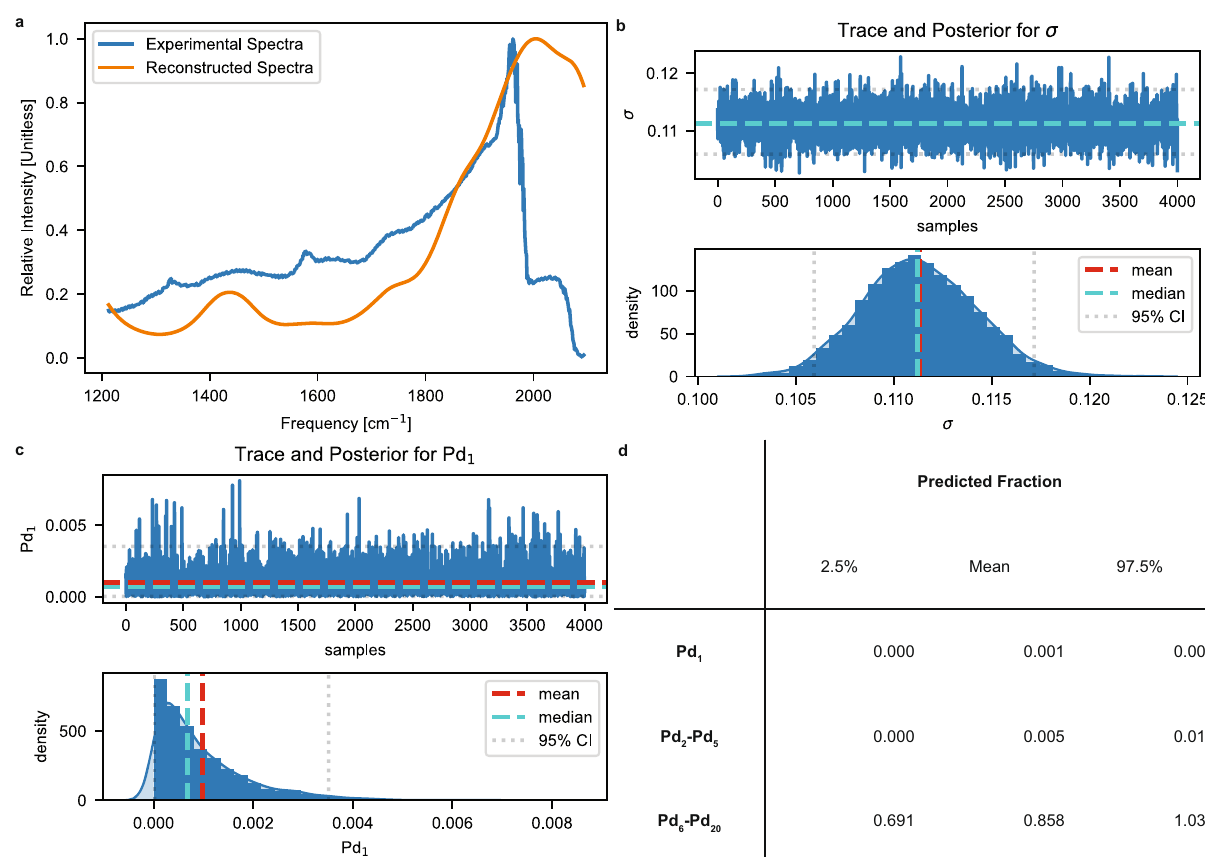
credible intervals (CI)ofthe predicted fractions for Pd 1 and bins of Pd 2 -Pd 5 , aswell as Pd 6 -Pd 20 . There is little evidence to suggest single atoms or small monolayer clusters (<6 atoms) on the catalyst. We fi nd that the supported particles are likely large multilayer